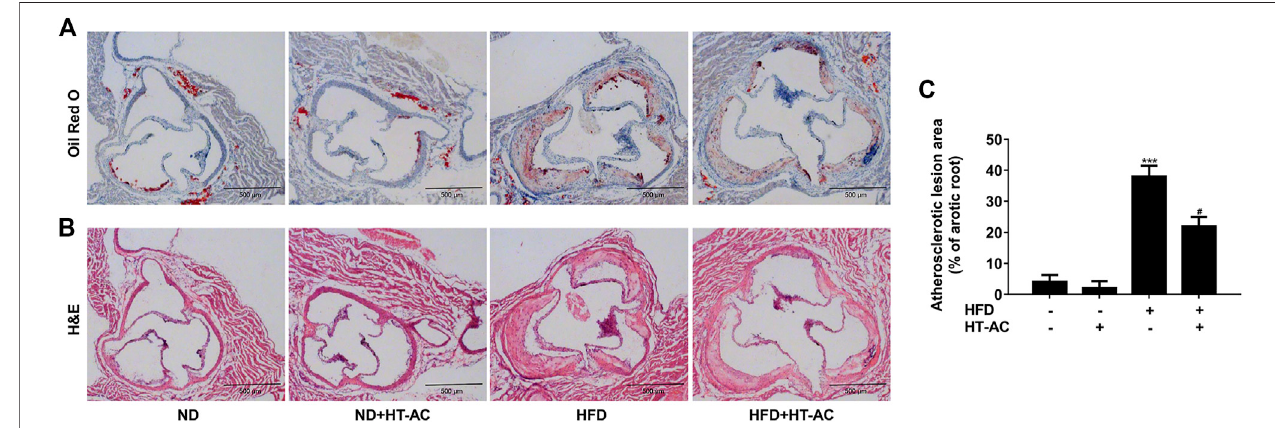
FIGURE1| HT-ACattenuatedtheformationofatheroscleroticlesionsinApoE − / − mice.ApoE − / − micewithNDorHFDwithorwithoutHT-ACtreatment(20 mg/kg/day) for 12 weeks (A) Representative images showing the lipid deposition of aortic root sections with Oil red O staining, × 100 (B) Representative images showing the atherosclerotic lesions of aortic root sections with H&E staining, × 100. Scale bar indicates 500 μ m (C) The atherosclerotic lesion area of aortic root sections was analyzed. *** p < 0.001 vs. ND group; # p < 0.05 vs. HFD group. Results are expressed as mean ± SEM ( n (cid:2)